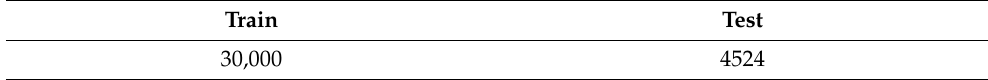
Table 7. Dataset for model